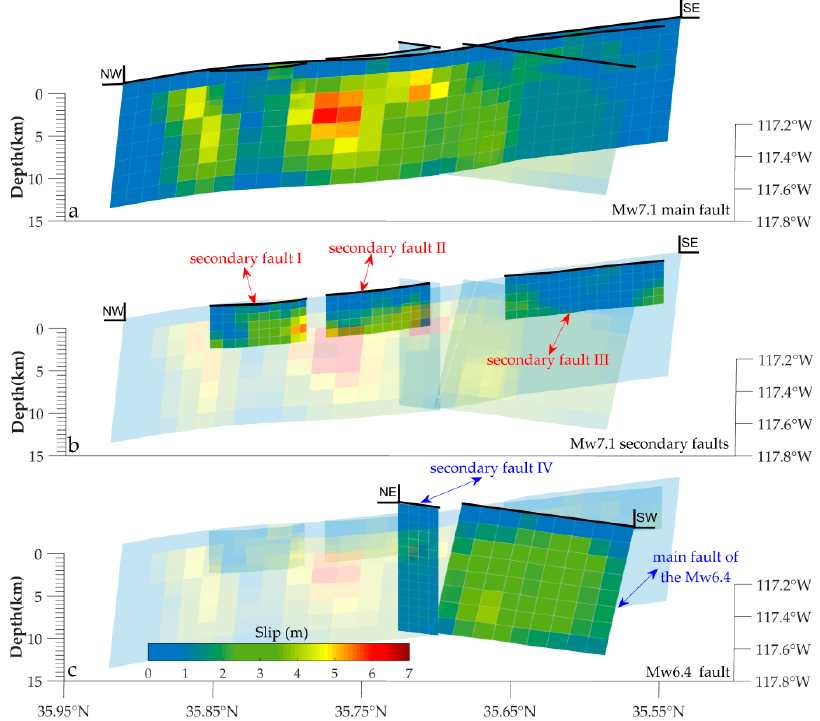
Figure 9. The slip distribution model of the multiple faults: ( a ) Mw7.1 main fault, ( b ) Mw7.1 secondary faults, and ( c ) Mw6.4 main fault.